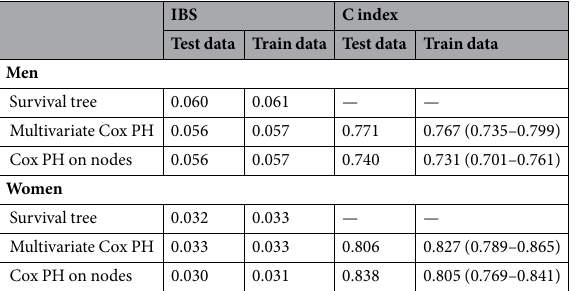
Table 6. Performance of the Cox PH and survival tree models among train and test samples; Tehran Lipid and Glucose Study (1999–2012). IBS: Integrated Brier score; is defined as the squared difference between true event status at given time and the predicted event status at that time. C index: Harrell’s C-index; is defined as the fraction of pairs in the data, where the observation with the higher survival time has the higher probability of survival predicted by the model. Number of subjects in train data for men = 2,805; Number of subjects in test data for men = 936. Number of subjects in train data for women = 3,403; Number of subjects in test data for men =